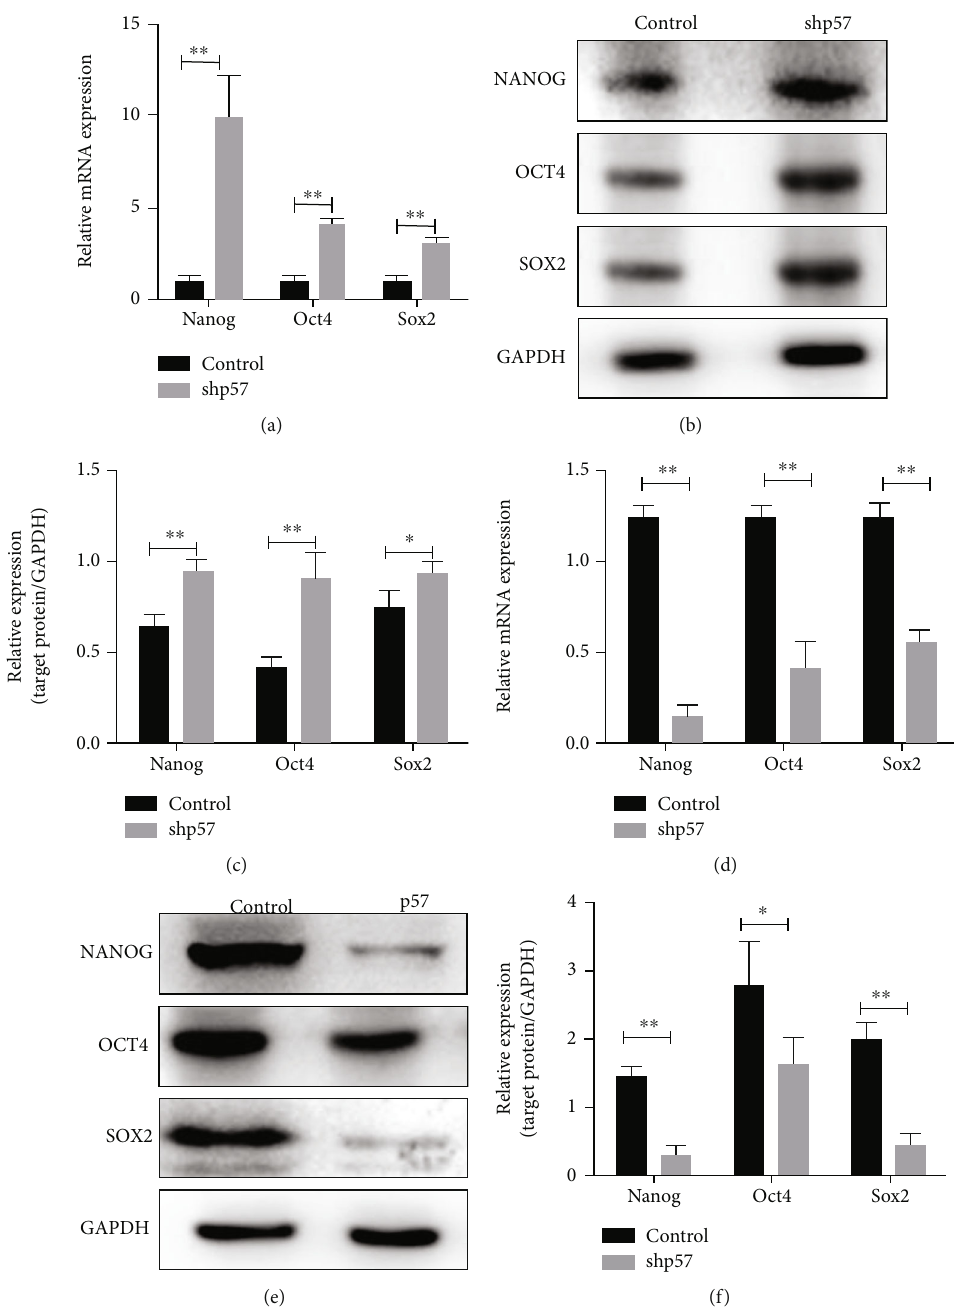
Figure 2: p57 suppressed the pluripotency state of mESCs. (a) Real-time PCR analyses of Nanog , Oct4 , and Sox2 expression levels in control ( n = 3 ) and p57 knockdown (shp57, n = 3 ) mESCs. (b, c) Western blot and related densitometric analyses of NANOG, OCT4, and SOX2 protein levels in control and p57 knockdown (shp57) mESCs cultured for 48h. (d) Real-time PCR analyses of Nanog , Oct4 , and Sox2 expression levels in control ( n = 3 ) and p57-overexpressing (p57, n = 3 ) mESCs cultured for 48 h. (e, f) Western blot and